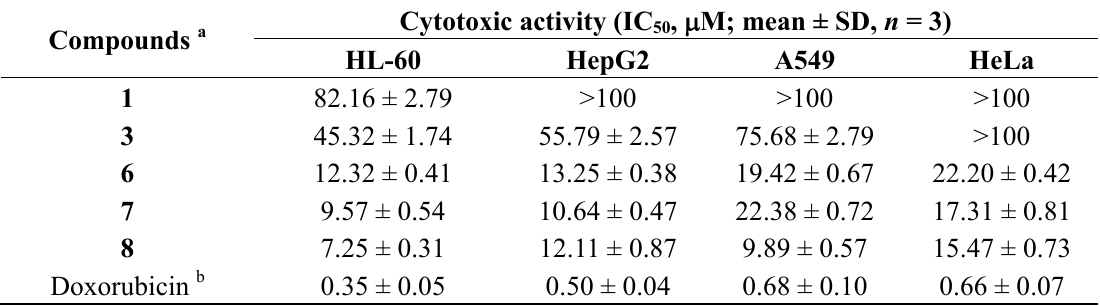
Table 3. Cytotoxic activity of compounds 1  10 against four human cancer cell lines in vitro . Compounds